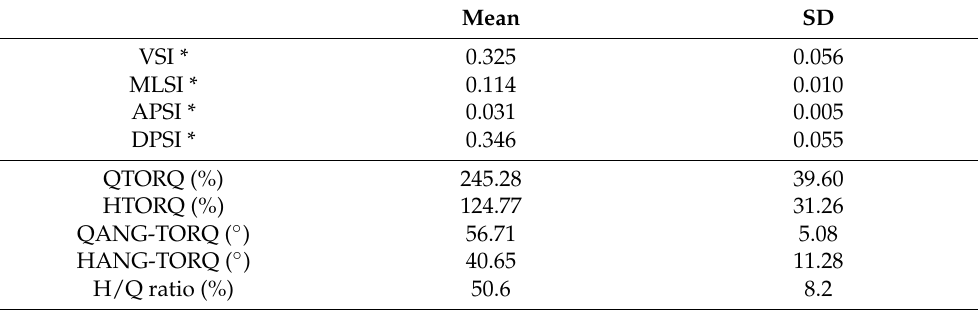
Table 1. Descriptive parameters of isokinetic strength and Dynamic postural